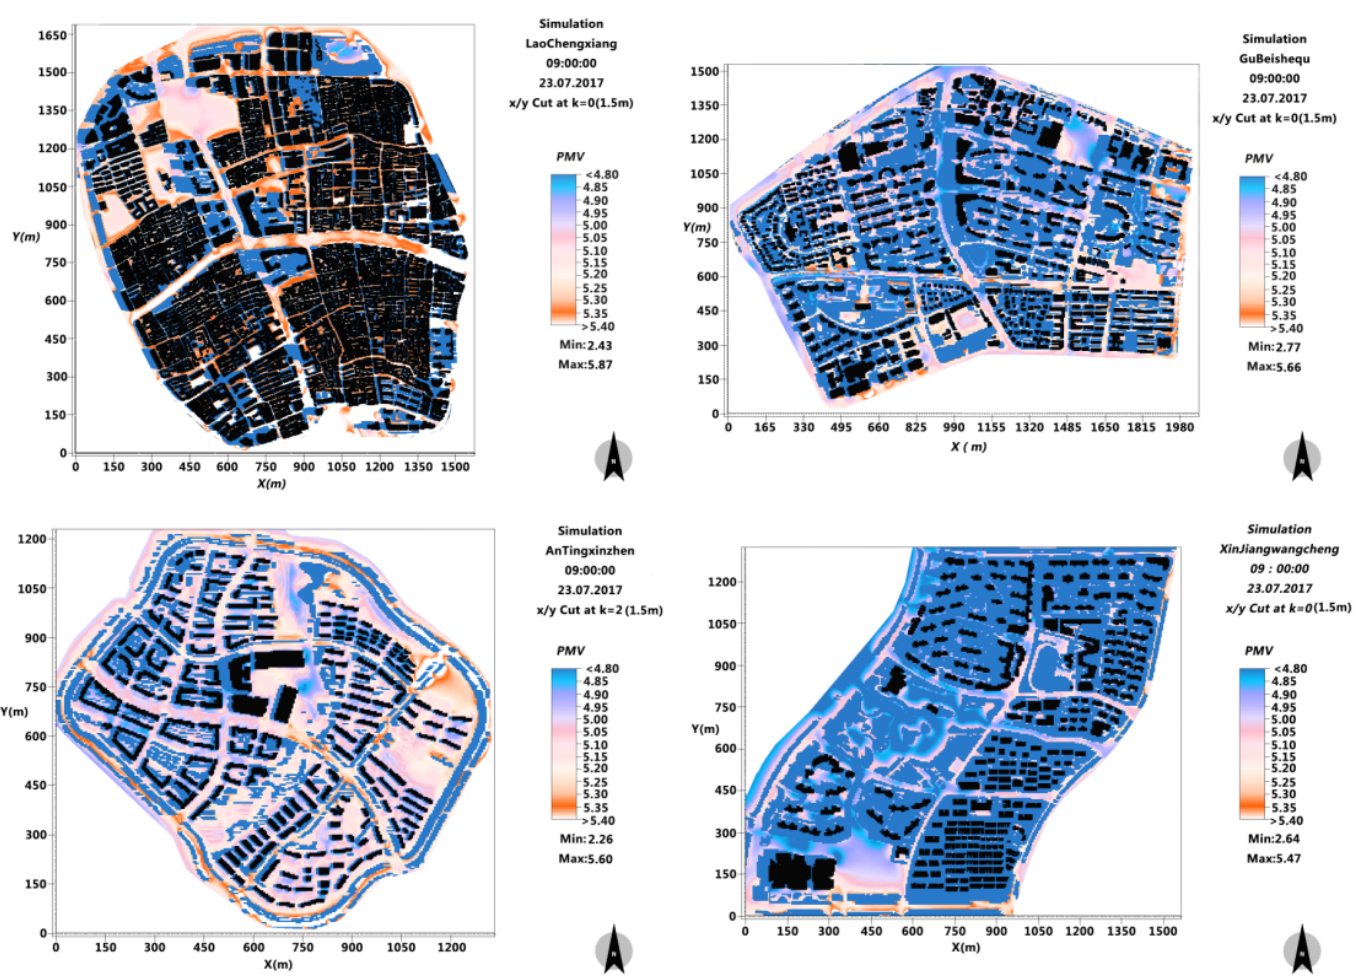
Figure A3. Spatial distribution of the PMV values in the four areas at 9:00 p.m., 1.5 m (left upper: Old downtown; right upper: Gubei international community; left lower: Anting New Town; lower right: New Jiangwan Town).